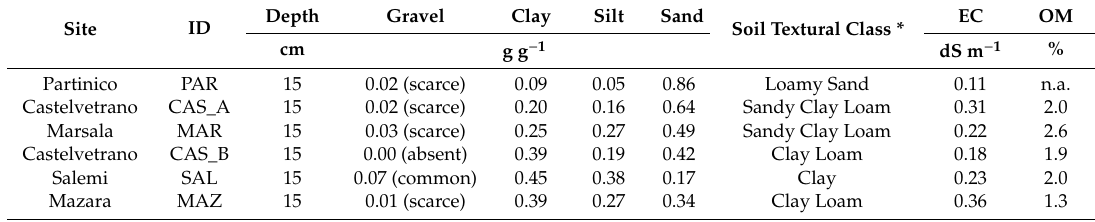
Table 2. Physical and chemical attributes of the investigated